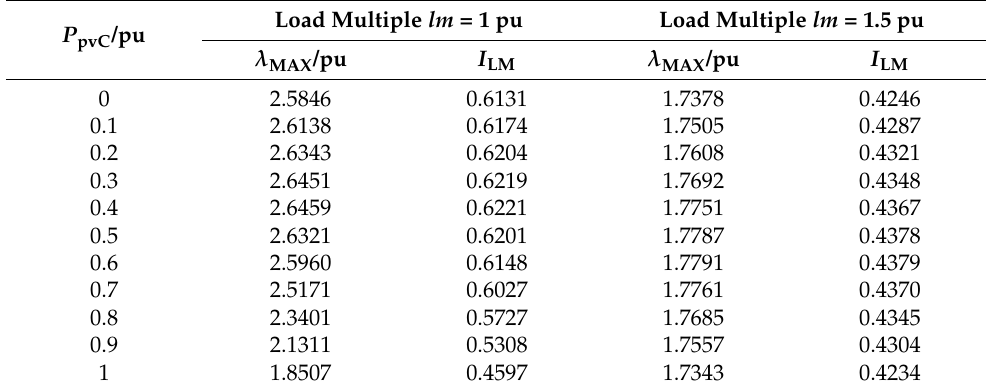
Table 6. Values of system load-margin index (Plan C, active output of PV station B P pvB = 0.3 pu).